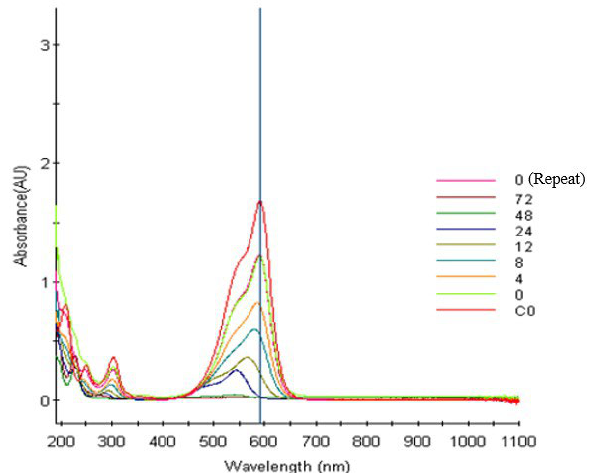
Figure 8. Temporal variations in the UV–vis adsorption of the aqueous BiO m Cl n /BiO p I q /g-C 3 N 4 - 20% photocatalyst prepared under a KCl:KI molar ratio of 1:2, a hydrothermal temperature of 250 °C, and a pH of 4 during the photocatalytic degradation of CV on the photocatalyst under visible- light irradiation.